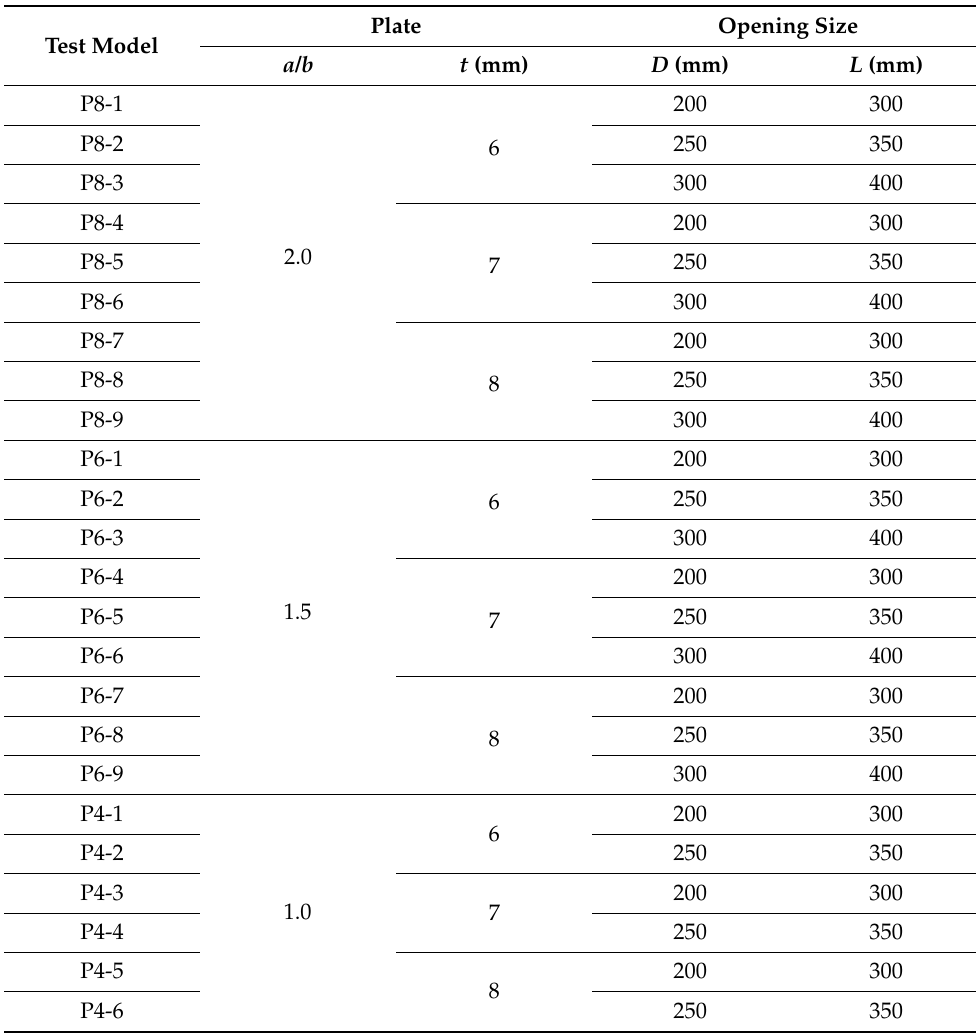
Table 2. Scenario and dimensions of the perforated